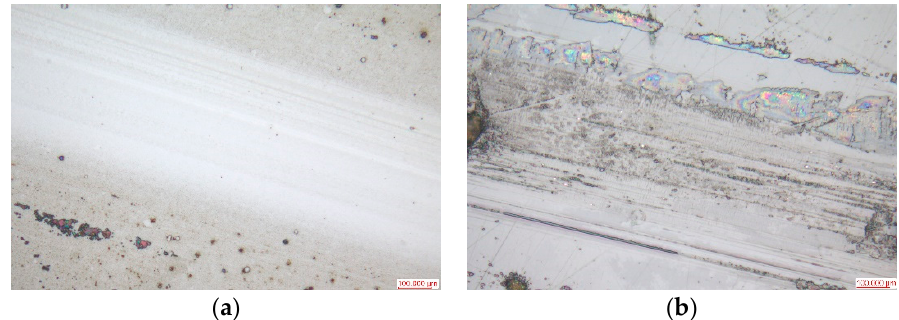
Figure 12. Wear tracks micrographs obtained by optical microscope of the Cr-DLC films deposited at set values of 2% ( a ) and 20% ( b ).